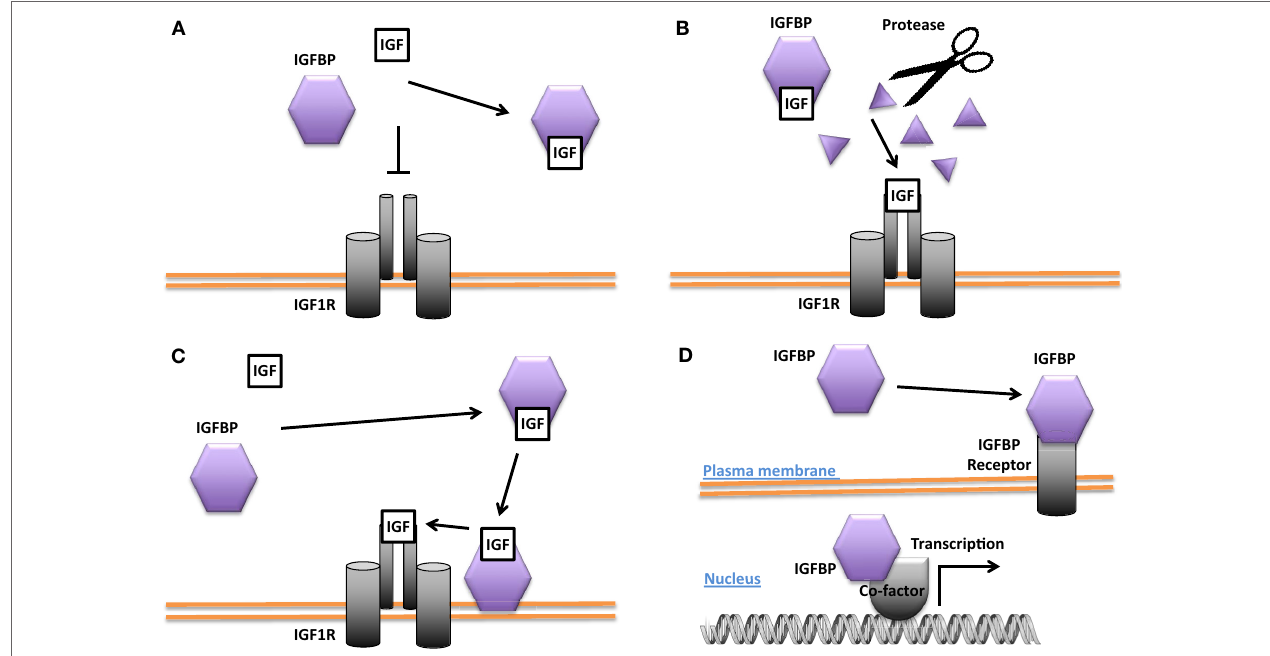
FiGURe 2 | Different modes of Insulin-like growth factor-binding protein (IGFBP) actions. (A) Inhibition of insulin-like growth factor (IGF) signaling by sequestering IGFs away from the IGF-1 receptor (IGF1R). (B) Promotion of IGF signaling by proteolytic cleavage of the IGFBP and liberation of IGFs from the IGF/IGFBP complex for binding to the IGF1R. (C) Enhancement of IGF signaling by concentrating IGF locally and increasing IGF availability for binding to the IGF1R. (D) IGF-independent actions. Some IGFBPs have been shown to be capable of translocating into the nucleus in certain cells and may affect gene transcription directly or indirectly. Some IGFBPs have been found to bind to cell surface proteins that may act as IGFBP